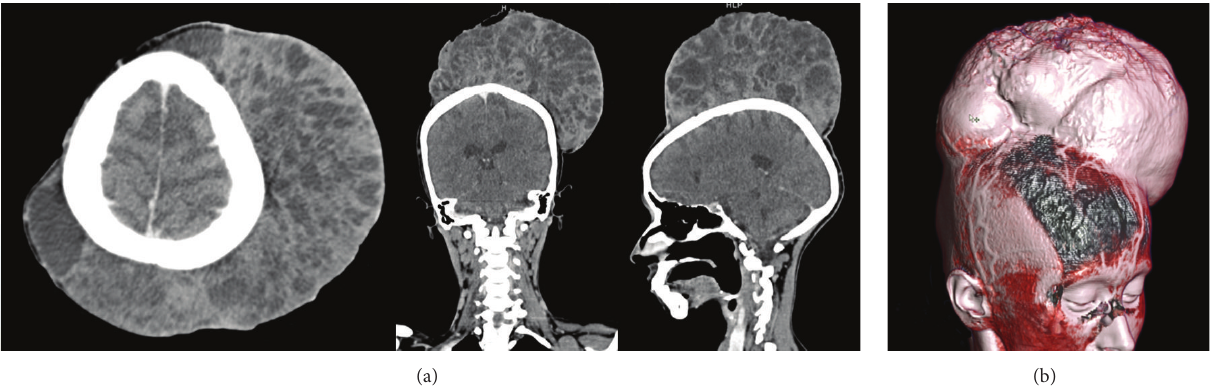
Figure 2: Computed tomography (CT) scan with 3D reconstruction showing highly vascular tumour with clean surgical plane with underlying calvarium.